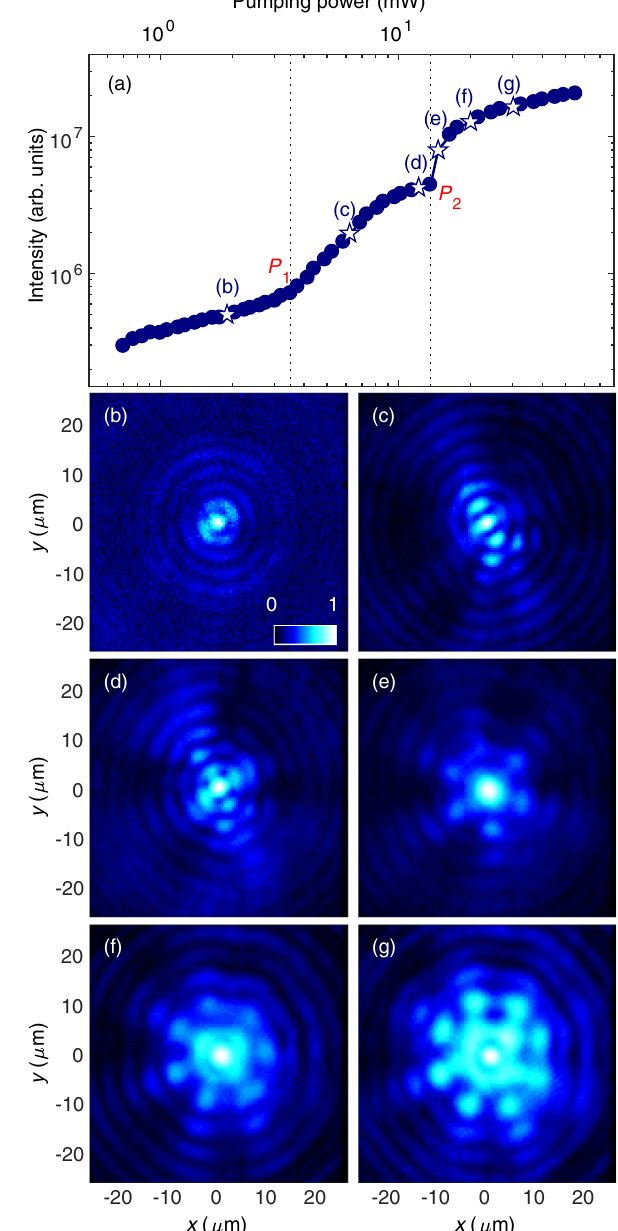
FIG. 2. Pump power dependence. (a) Integrated emission intensity as a function of pump power. The unfilled stars are pumping powers corresponding to the real-space density distri- butions shown in (b) – (g). P 1 and P 2 mark the onset of parametric scattering and bistability, respectively. (b) At low pumping powers we observe a Bessel distribution of polaritons. Above P 1 we form patterns with two (c) and four (d) bright lobes. Above P 2 patterns with six (e), seven (f), and eight (g) bright lobes emerge. The data are plotted on a log scale and